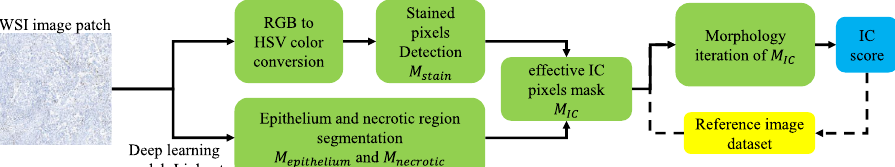
Fig. 6 Overall pipeline of the AI-assisted model. The AI model had two parallel threads: the fi rst thread detected and segmented all staining cells; the second thread segmented tumor epithelium and necrotic regions. The ICs were obtained by combining the results of the two